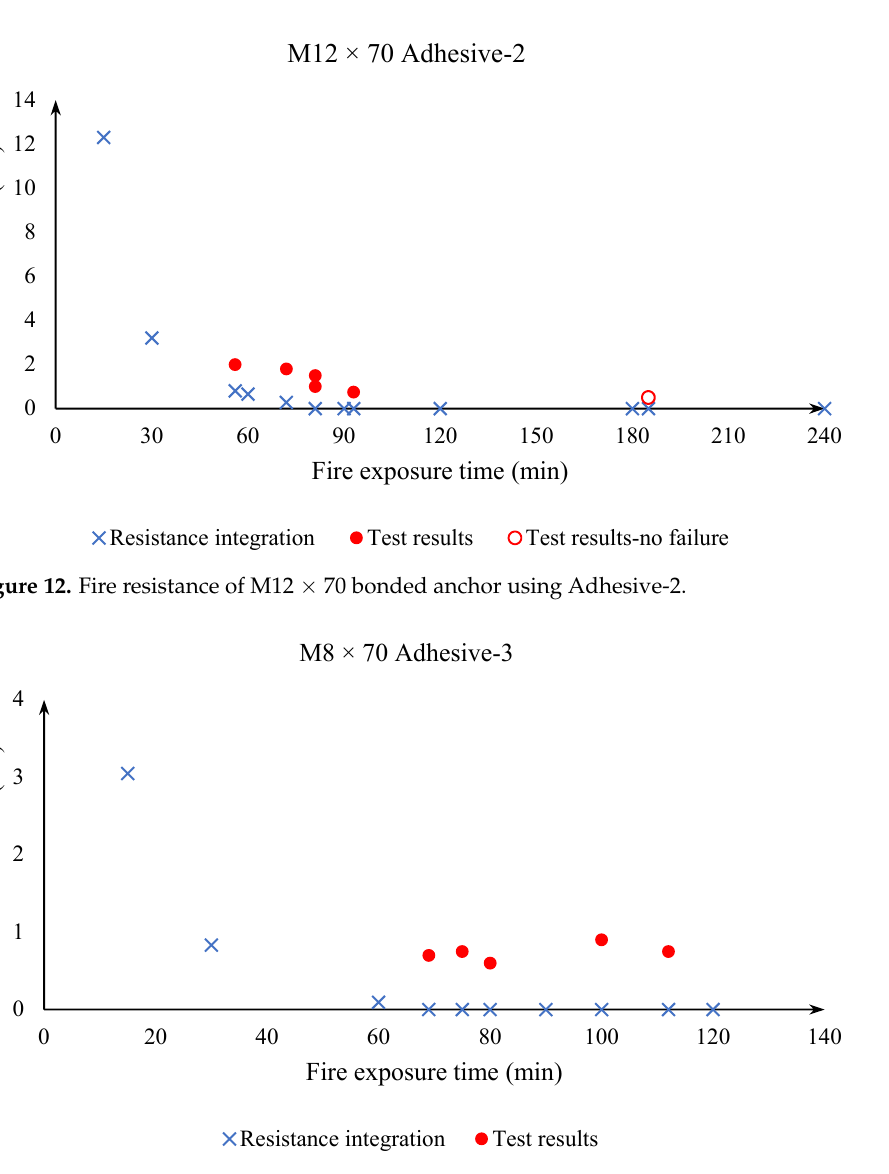
Figure 11. Fire resistance of M10 × 50 bonded anchor using Adhesive-1.